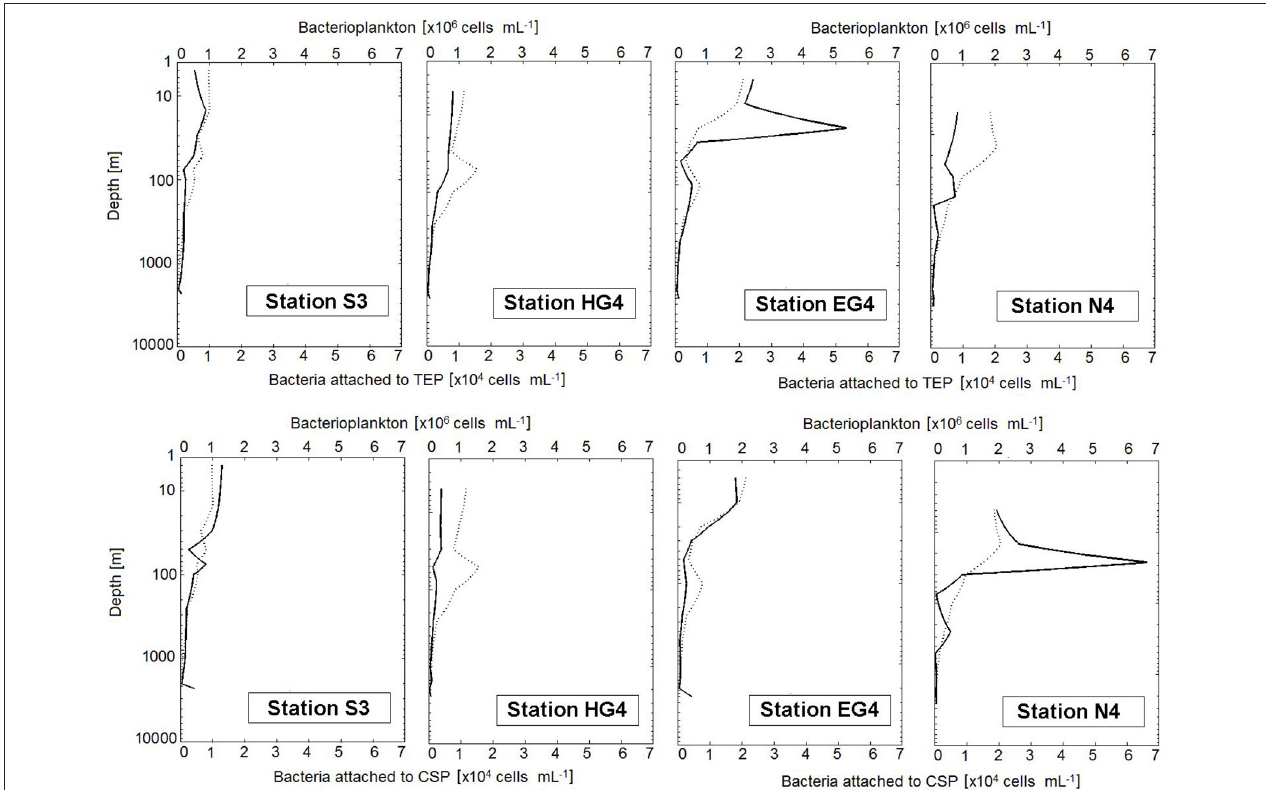
FIGURE 5 | Vertical depth profiles of bacterial cells. The dashed line represents the interpolated behavior of the bacterioplankton curve (measured by flow cytometry). The continuous line shows bacteria attached to gel particles (determined by microscopy). Note that bacterioplankton concentrations are given in × 10 6 (cells per volume of seawater [mL − 1 ]), while concentrations of bacteria attached to gel particles are scaled two orders of magnitude lower and therefore given in × 10 4 (cells per volume of seawater [mL − 1 ]). Y-axis has logarithmic scaling.